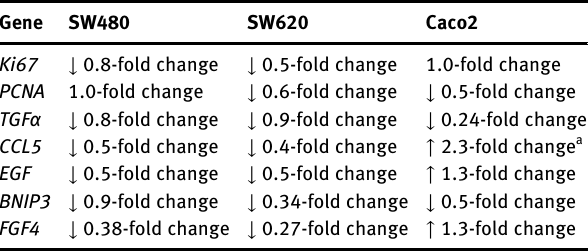
Table  : Summary of the mRNA expression of genes related to cellular mechanisms in clusterin-silenced SW  , SW  and Caco  after  h. A  .  -fold change indicated the relationship be- tween the normalised GOI in clusterin-silenced and non-clusterin- silenced cells